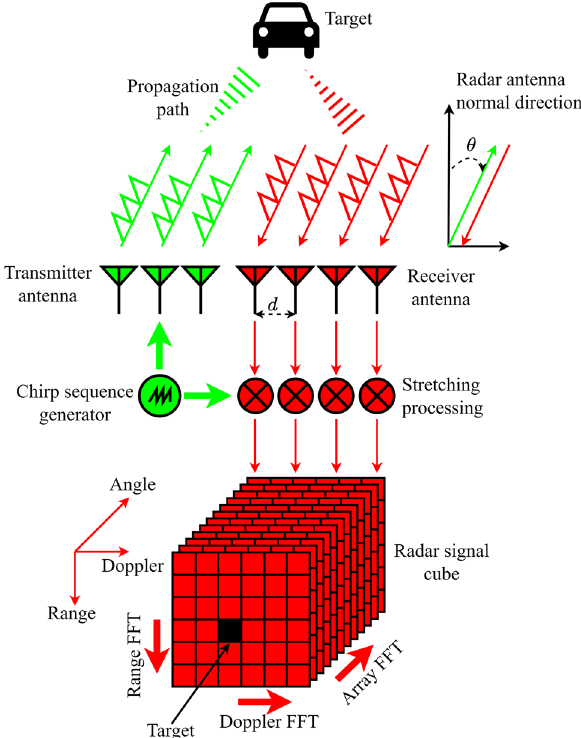
Figure 1. Signal processing flowchart of chirp sequence modulation and MIMO structure.